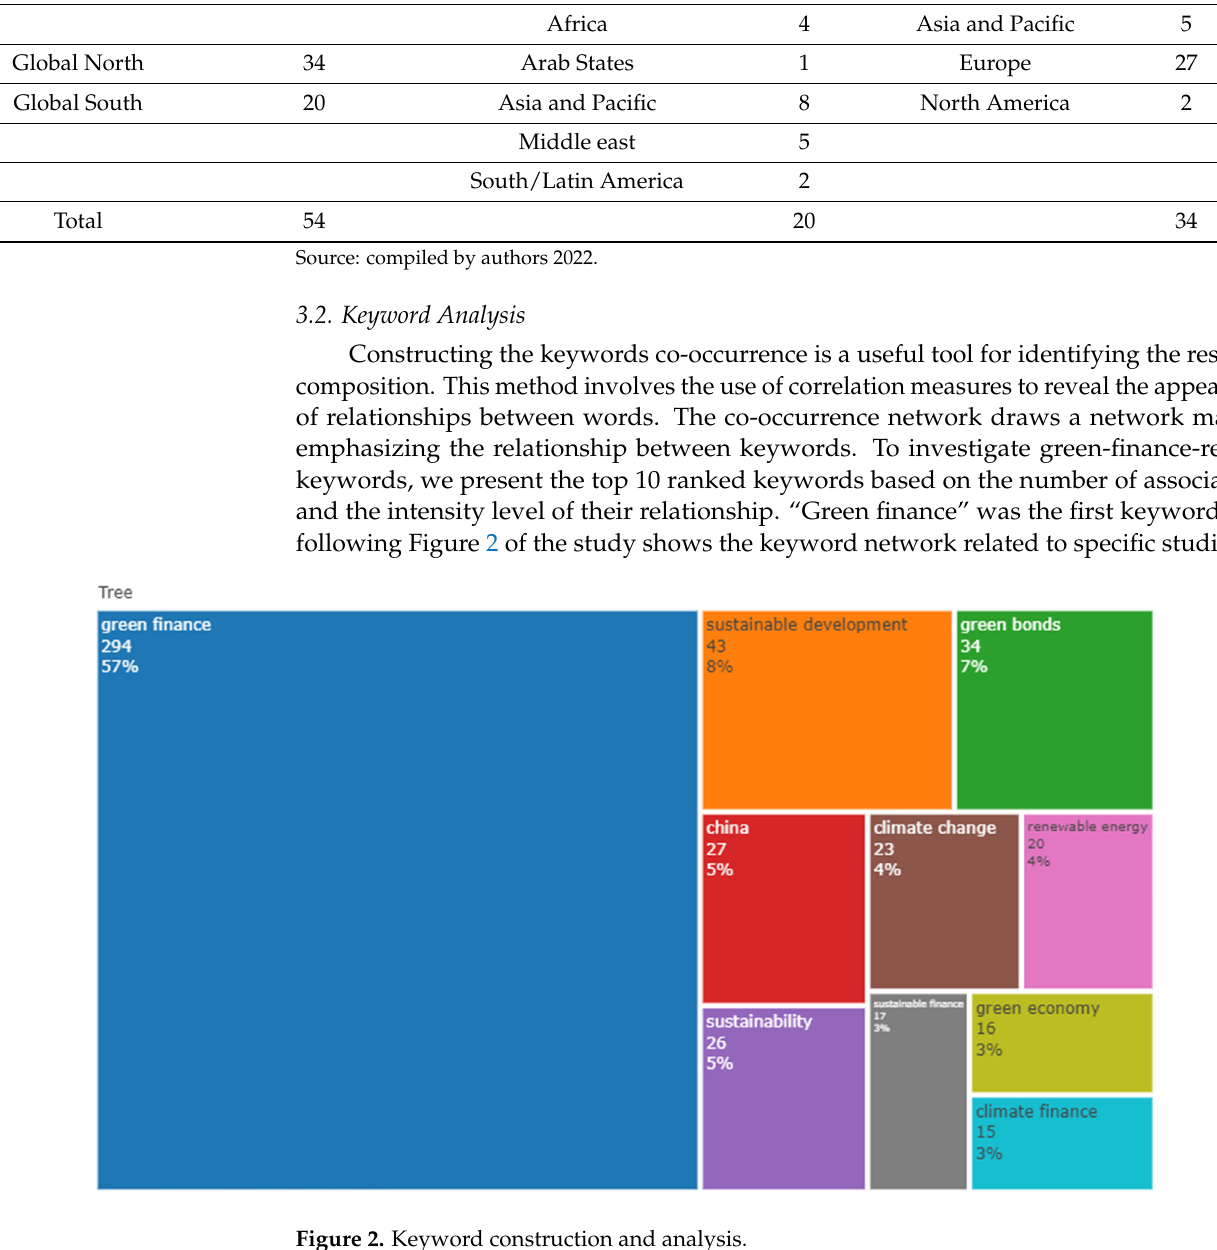
Figure 2. Keyword construction and